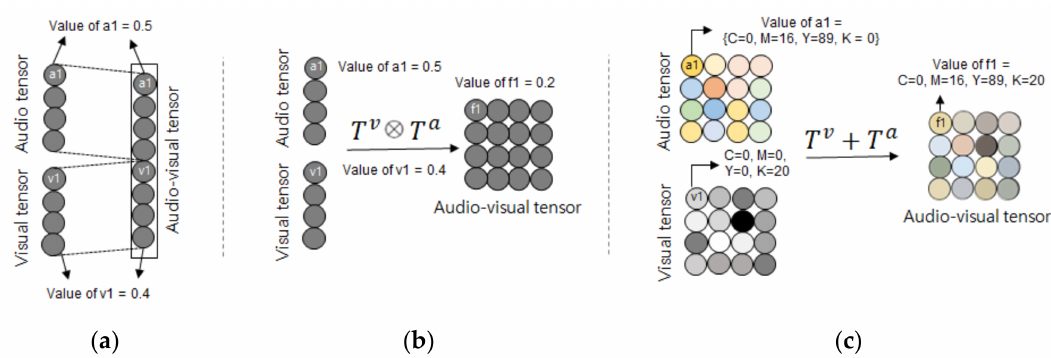
Figure 2. Comparison of the proposed data representation method with existing ones: ( a ) Simple concatenation (Adapted from [8,16]); ( b ) Cartesian product (Adapted from [17]); ( c ) proposed method